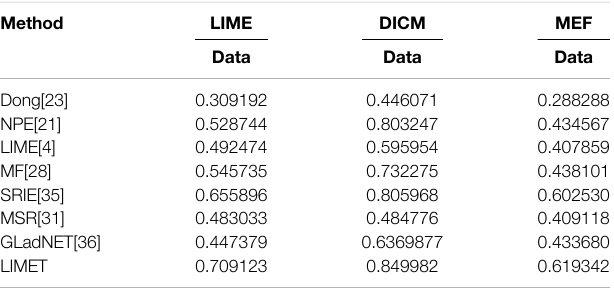
TABLE2| SummarizestheVIFresultsintheimagescomparedtothestate-of-the- art models.